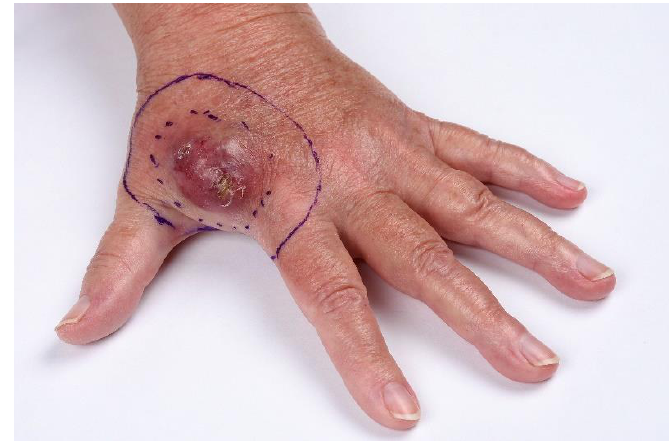
Figure 1. A red, nodular primary MCC on the left hand.